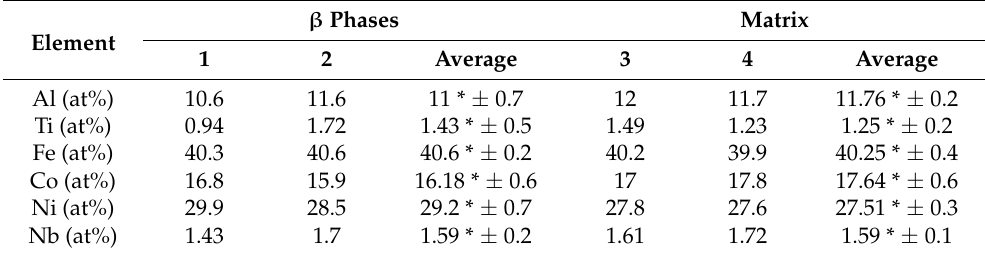
Table 1. The composition measurements of the FeNiCoAlTiNb alloy after 600 ◦ C—24 h. β Phases Element